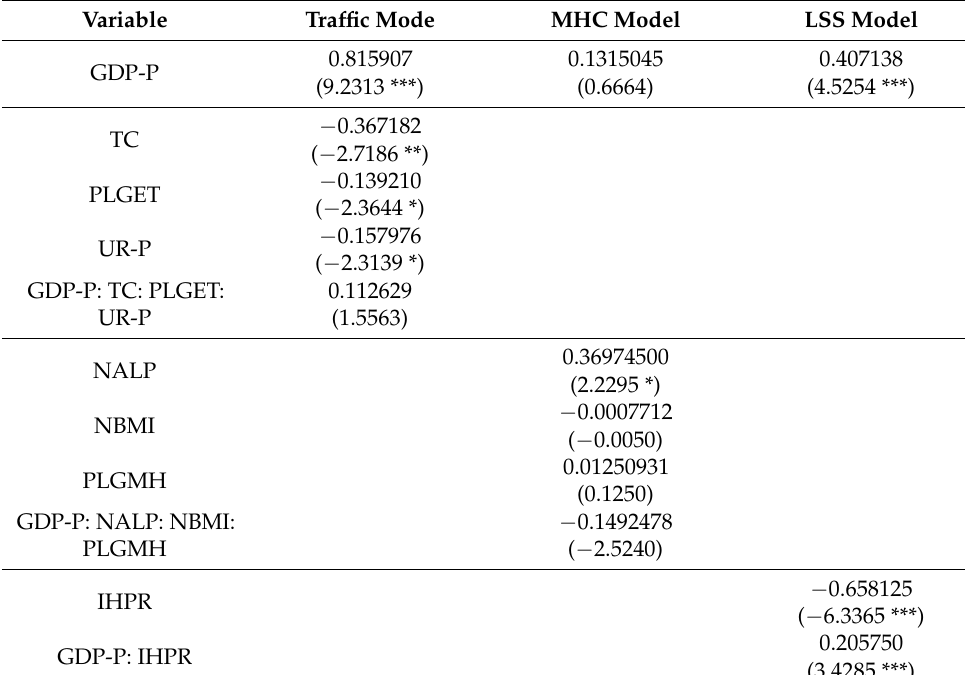
Table 6. Fixed Model results of life satisfaction and Traffic, MHC and LSS